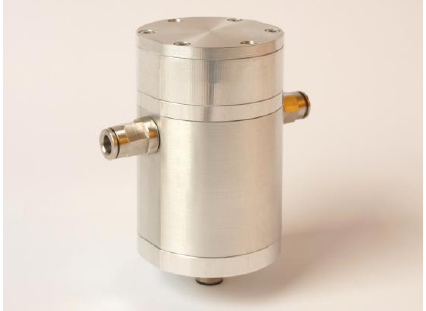
Figure 6. Assembled NDIR oil sensor prototype featuring 6mm push-in hose connectors on either side and an electrical connector at the bottom of the sensor housing.